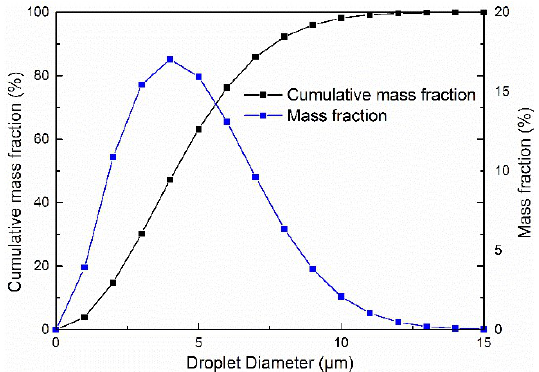
Figure 2. The distribution of the droplet diameter ( n = 2 and d e = 5 µ m).